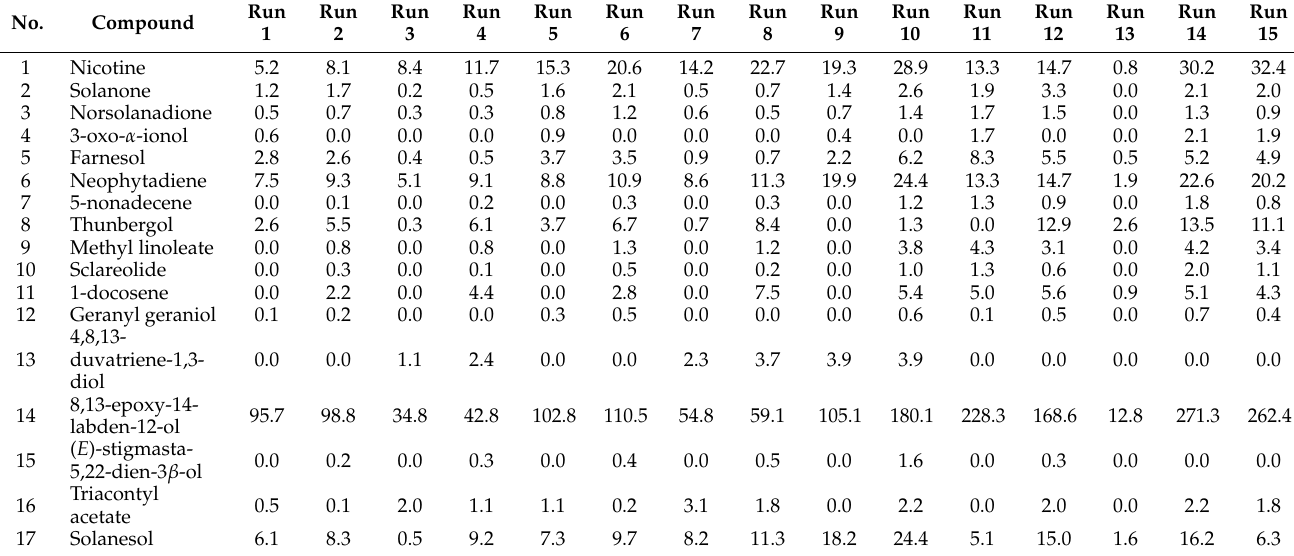
Table 6. The relative amount (in mg nicotine equivalents per 100 g of the plant material) of compounds in SC CO 2 extracts of N. tabacum cv. Virginia